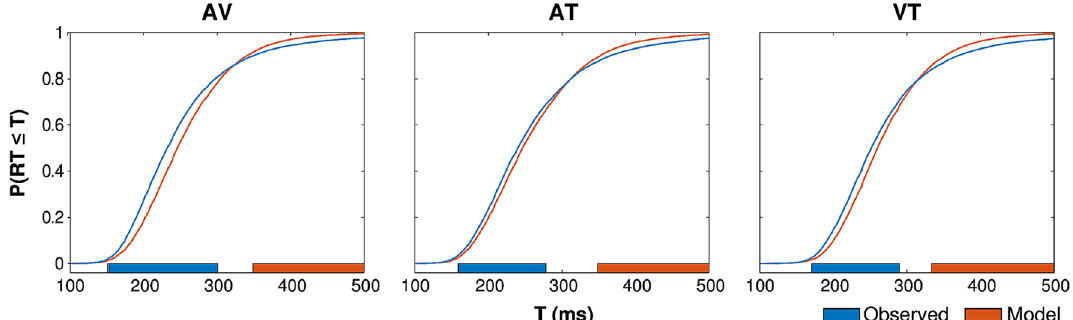
Figure 4. Comparisons of race model predictions (orange) and empirical RT distributions (blue) for audiovisual (“AV”), audiotactile (“AT”), and visuotactile (“VT”) trials. Colored bars at the bottom of each graph indicate time bins where the data and model differed significantly ( p < .05) after FWE correction. Blue bars indicate higher cumulative probability in the observed RT distribution, and orange bars indicate higher cumulative probability in the race